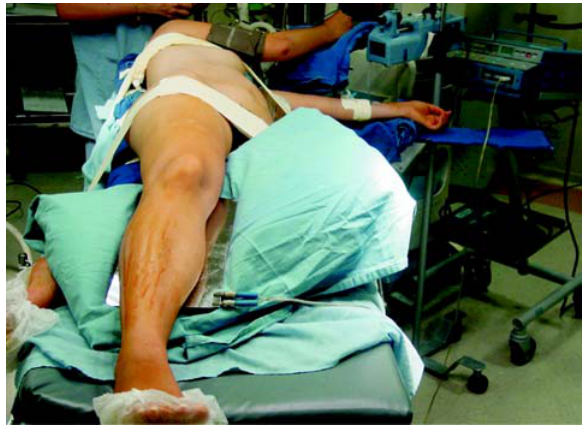
Figure 1 – The patient is placed in the 45-degree left lateral decubitus position with slight flexion of the operating table to extend the ipsilateral flank